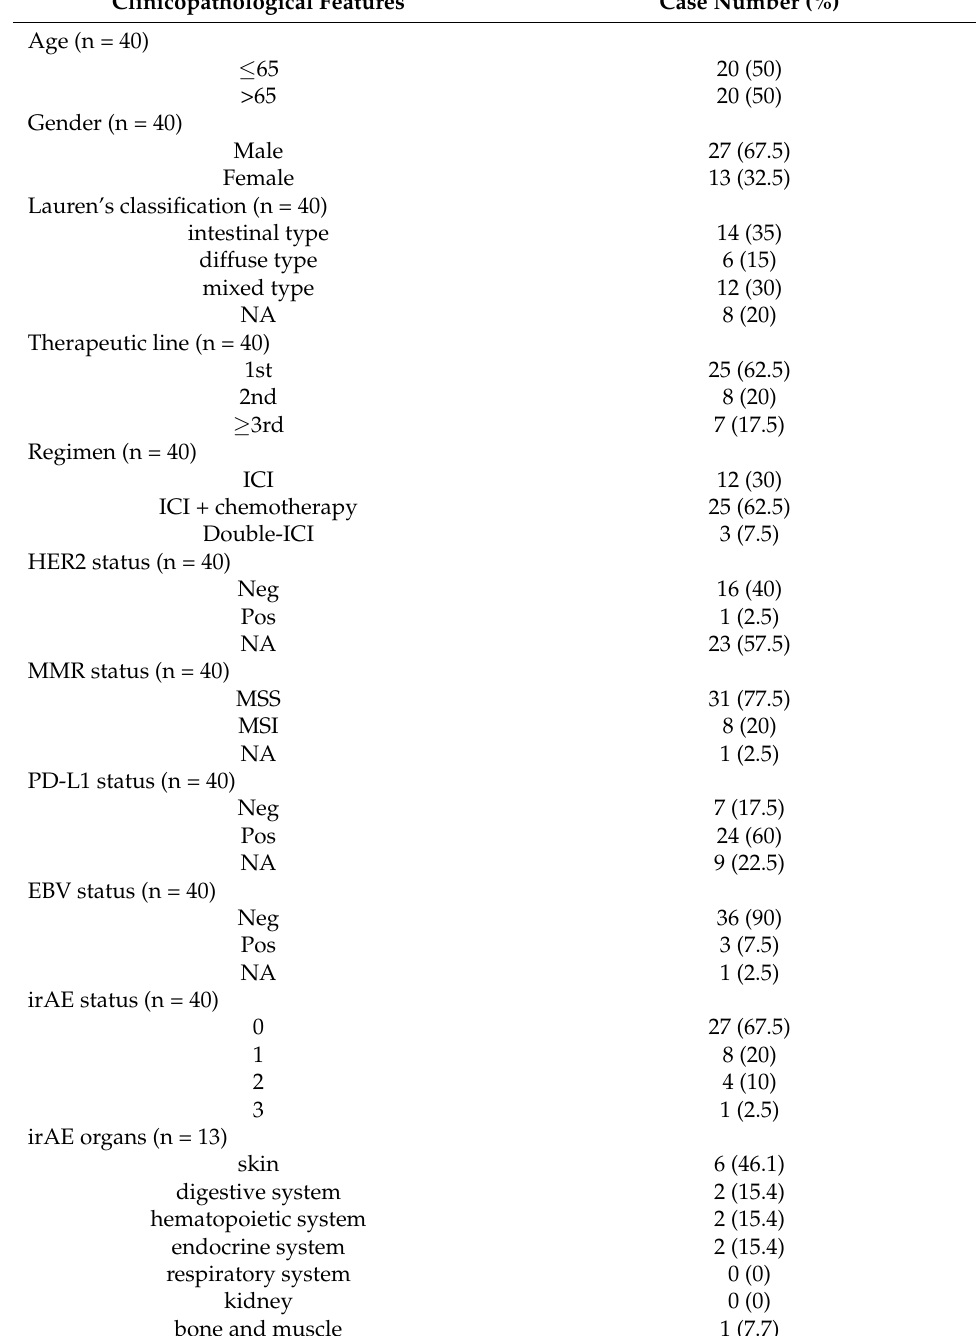
Table 3. Clinicopathological features of the validating cohort (n =